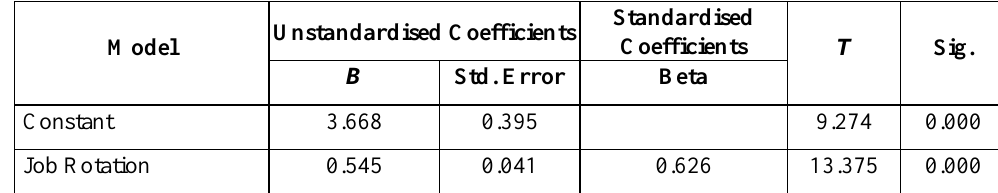
Table 5. Regression